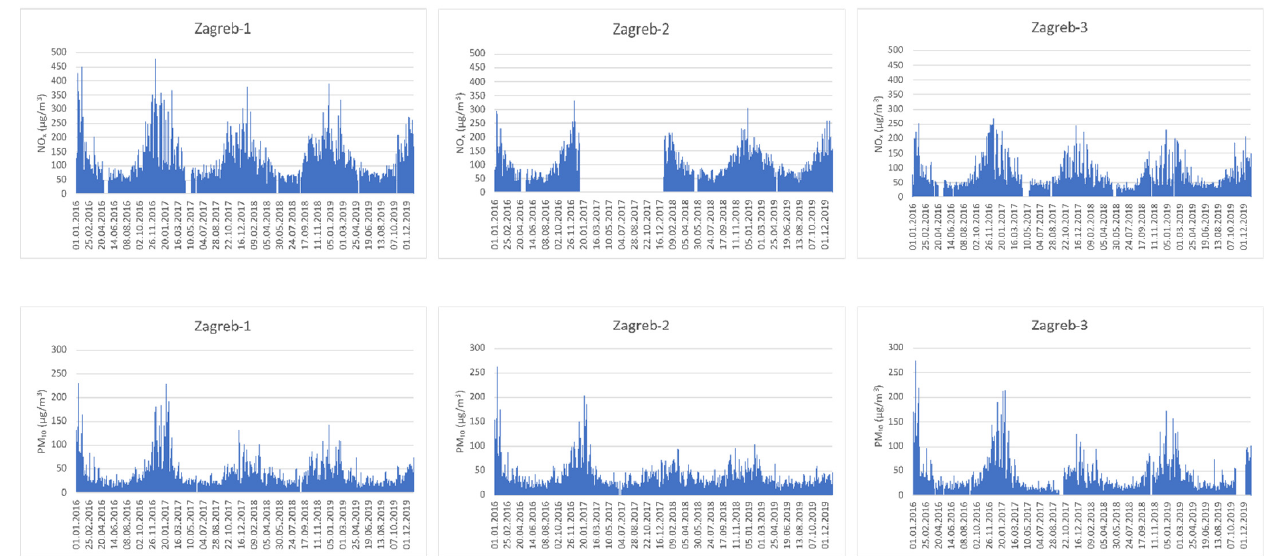
Figure 4. Air pollution in three different locations in Zagreb.